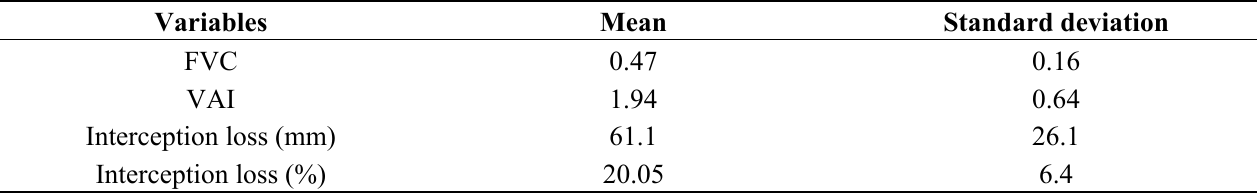
Table 4. The variation of Fractional Vegetation Cover (FVC), Vegetation Area Index (VAI) and interception loss (in mm and %) in the spatial from 13 June to 7 October 2008.